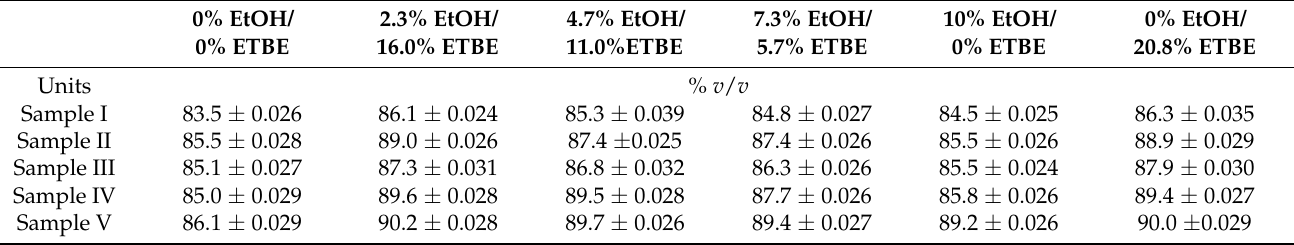
Table 10. E150 of base fuels and bio-EtOH/bio-ETBE